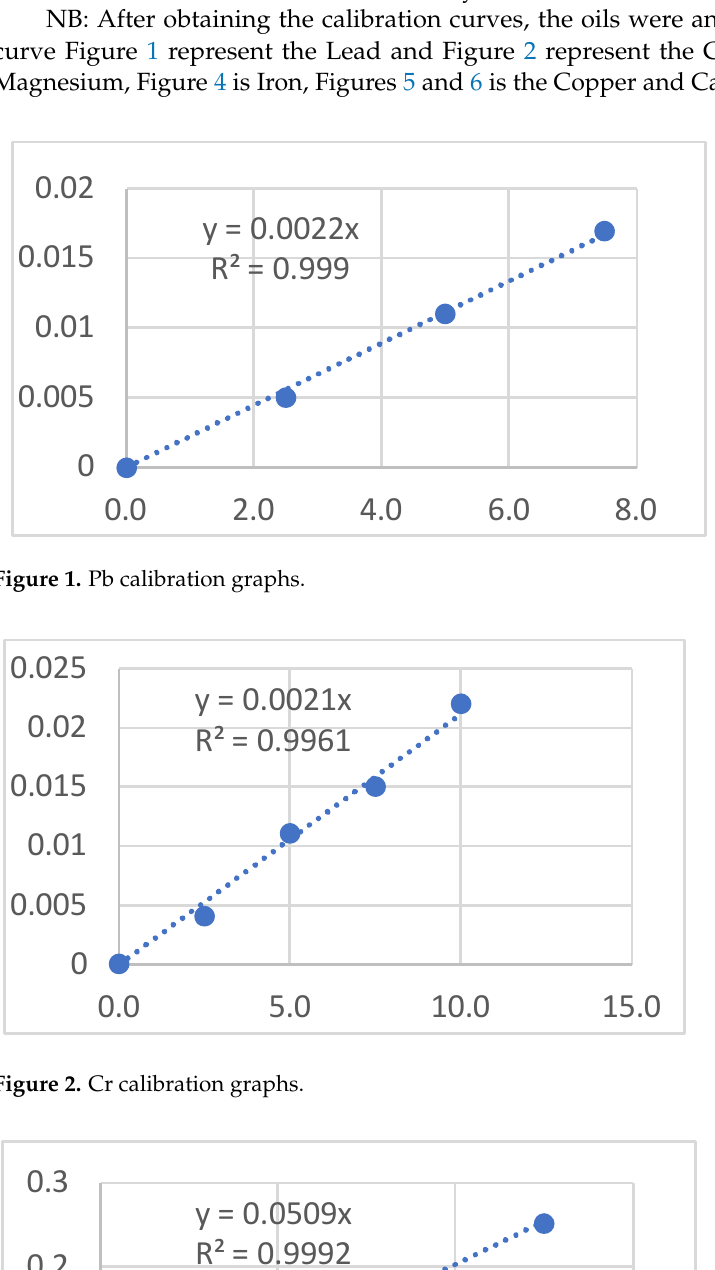
Figure 2. Cr calibration graphs.